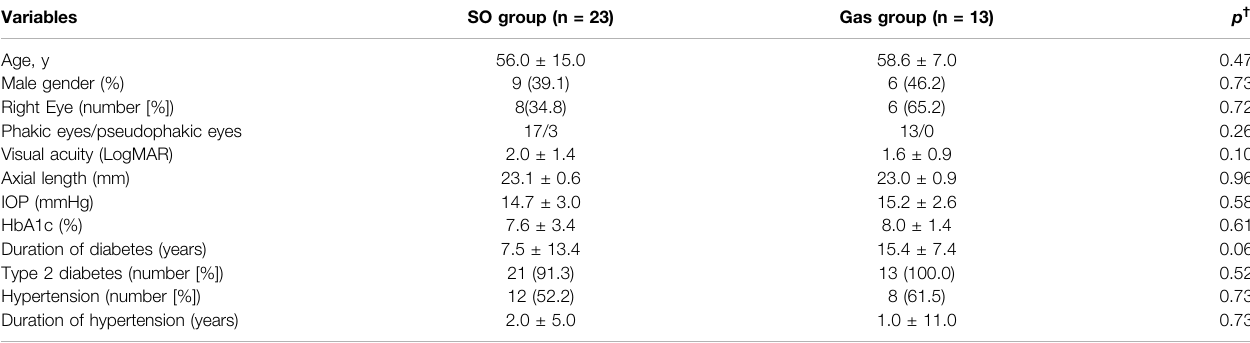
TABLE 1 | Baseline characteristics of subjects included in the analysis a